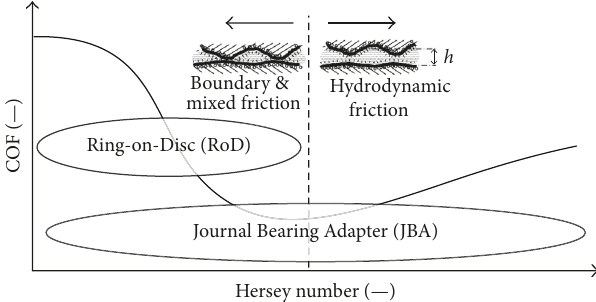
Figure 1: Possible operation regimes of the used test settings visualizedwiththehelpofaStribeckcurve.TheRing-on-Disc(RoD) setting allows investigations in the regime of boundary and mixed friction. The Journal Bearing Adapter (JBA) extends the possibilities to the fluid friction